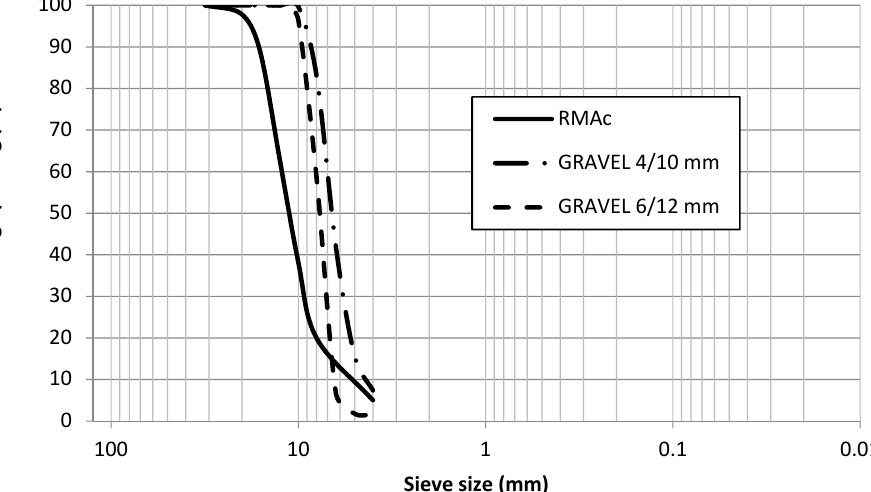
Figure 2. Particle size distribution of the coarse aggregates: natural (gravel) and recycled (RMAc). The recycled aggregates were obtained through mechanical treatment (crushing, sieving, and removal of impurities) of the CDW in a recycling plant located in the Autonomous Community of Madrid (Spain). The aggregate characterization carried out revealed differences between the recycled aggregates and natural aggregates. In terms of physical and mechanical properties such as D/d ratio, fines content [25], flakiness index [26], or Los Angeles coefficient [27], RMAc performed similarly to the natural aggregates, and the results were within the suitable range established by Reference [23] for concrete manufacture. However, results obtained following the tests specified in Reference [28] showed variations compared to the natural aggregates. The presence of attached mortar and ceramic